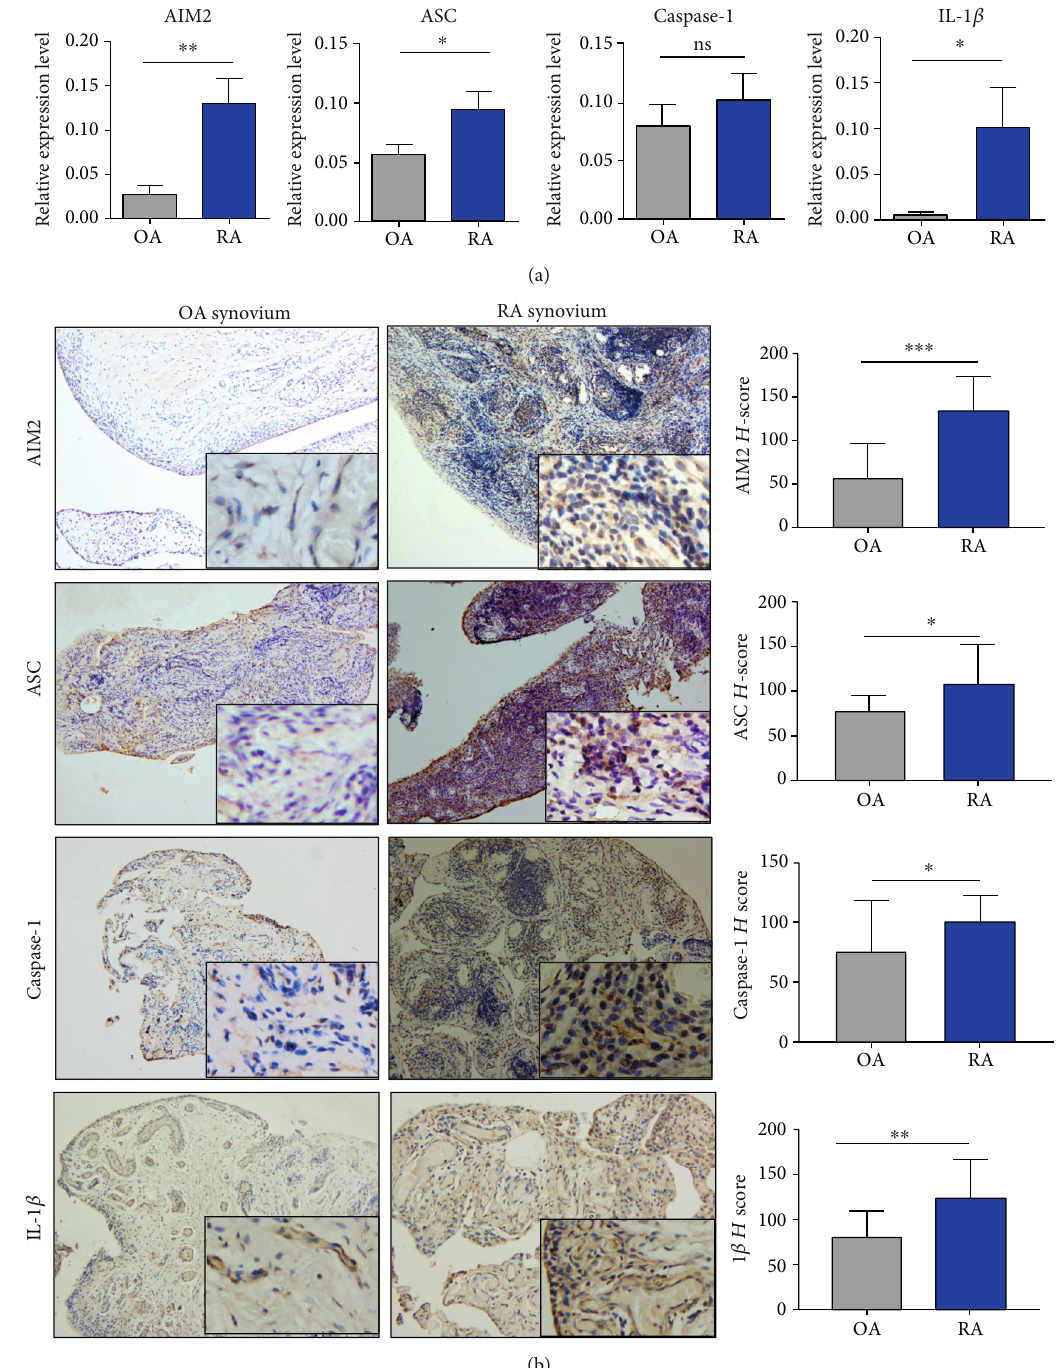
Figure 2: The di ff erences in AIM2 pathway-related molecules in synovium among OA and RA. mRNA AIM2 and AIM2 pathway-related proteins including ASC and IL-1 β were expressed higher in RA than in OA; caspase-1 was higher in RA than in OA without statistical signi fi cance (a). H score for the synovium of RA, AIM2, and AIM2 pathway-related proteins including ASC, caspase-1, and IL-1 β was more expressed than that of OA (b). ∗ p < 0 : 05 , ∗∗ p < 0 : 01 , and ∗∗∗∗ p < 0 : 0001